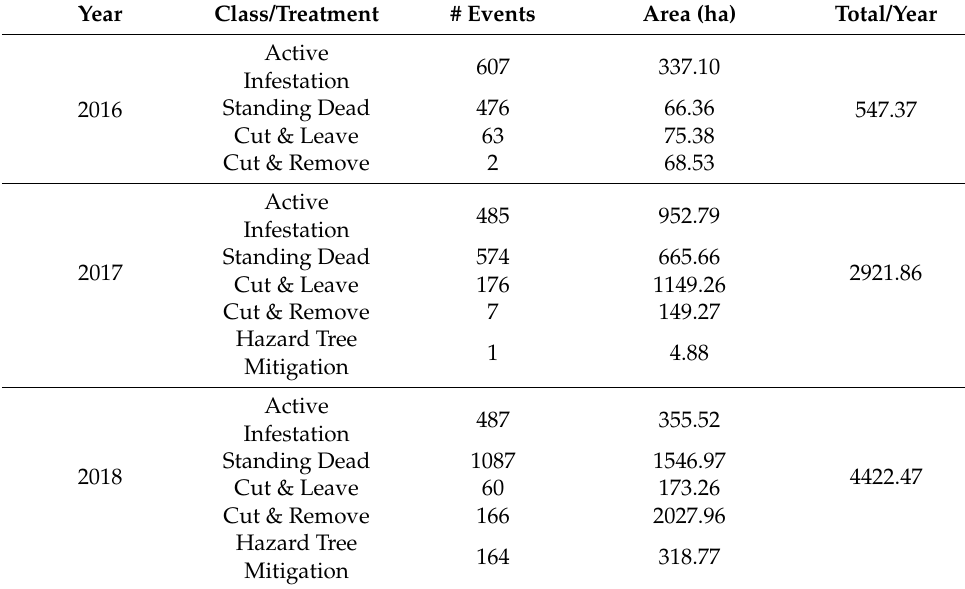
Table 3. Total acreage impacted by year and